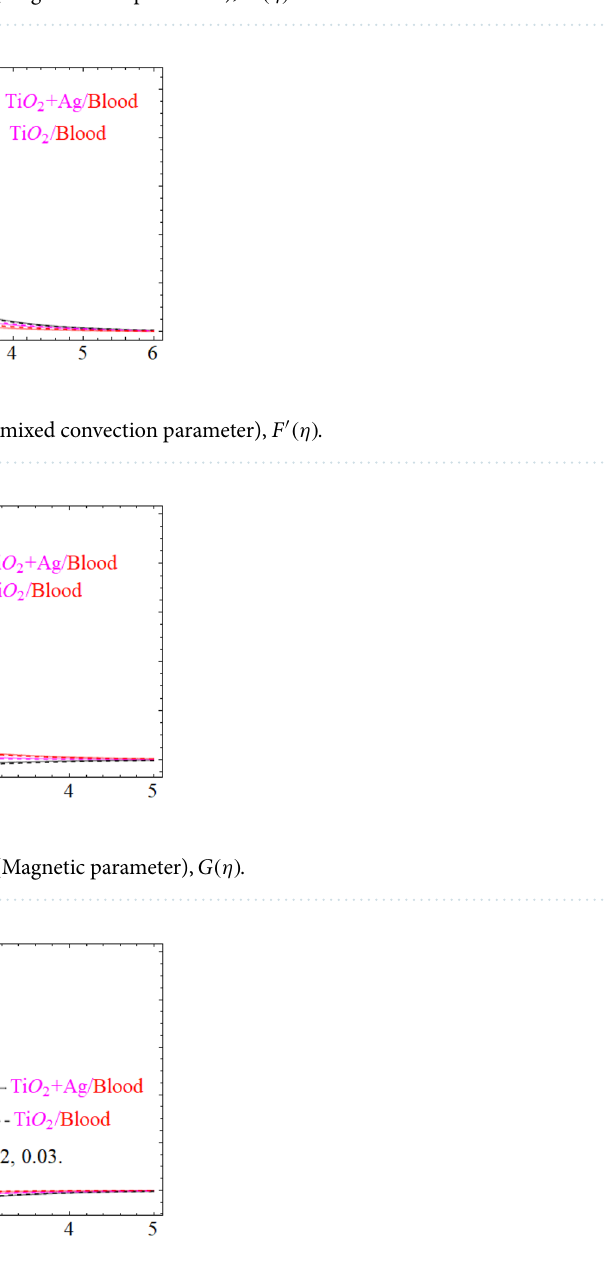
Figure 4. Under the influence of M (Magnetic field parameter), F ′ (η) .